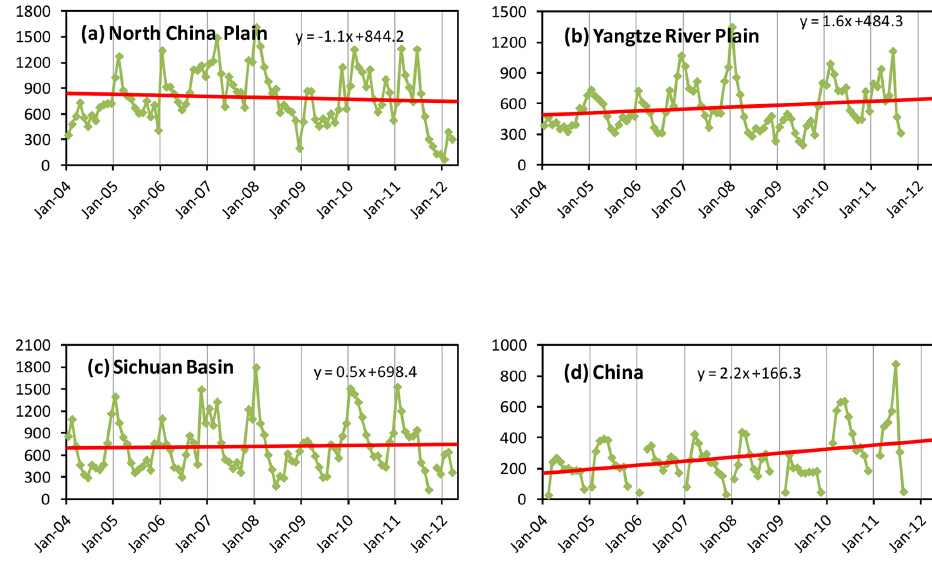
Figure 4. Trends of SO 2 concentration over China from SCIAMACHY for the years 2004–2012 (1000 × DU, Dobson unit).